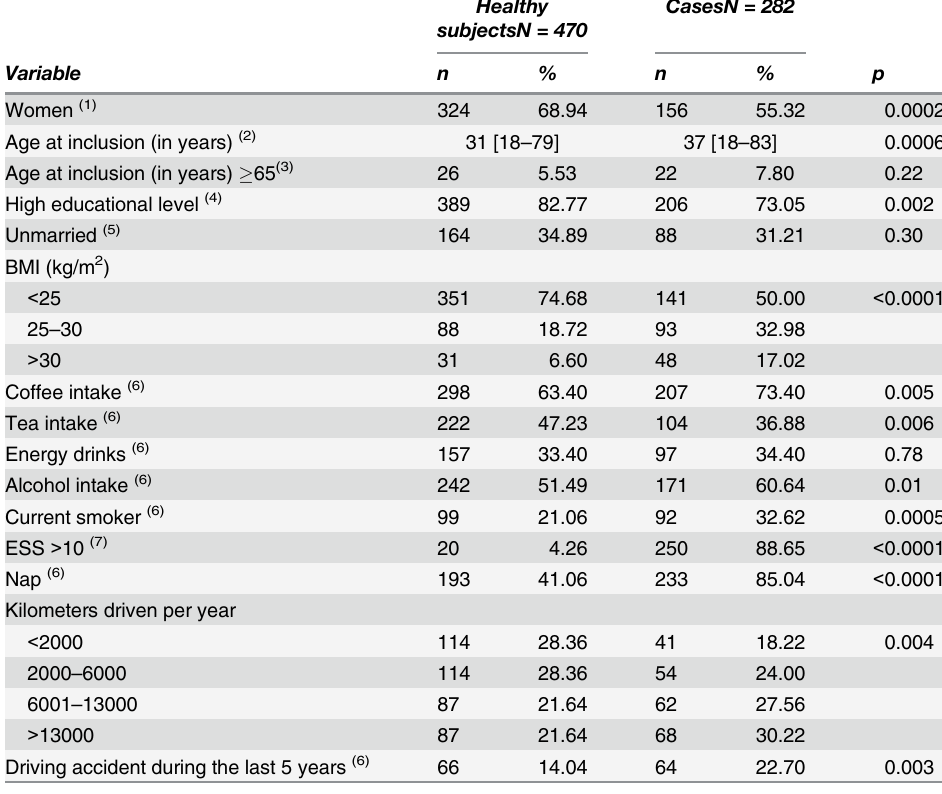
Healthy CasesN = 282 subjectsN = 470